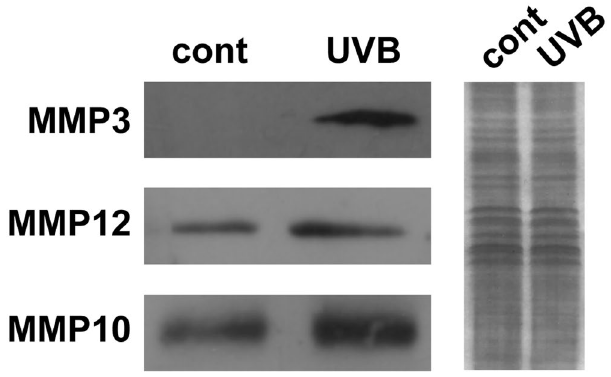
Figure 3. The protein levels of MMP3, MMP10 and MMP12. Protein levels were detected by Western blot analysis in control and UVB-treated HKerE6SFM cells. Loading controls are represented by Coomassie Brilliant Blue staining. The grouping of blots were cropped from different gels as shown in Supplementary Figure